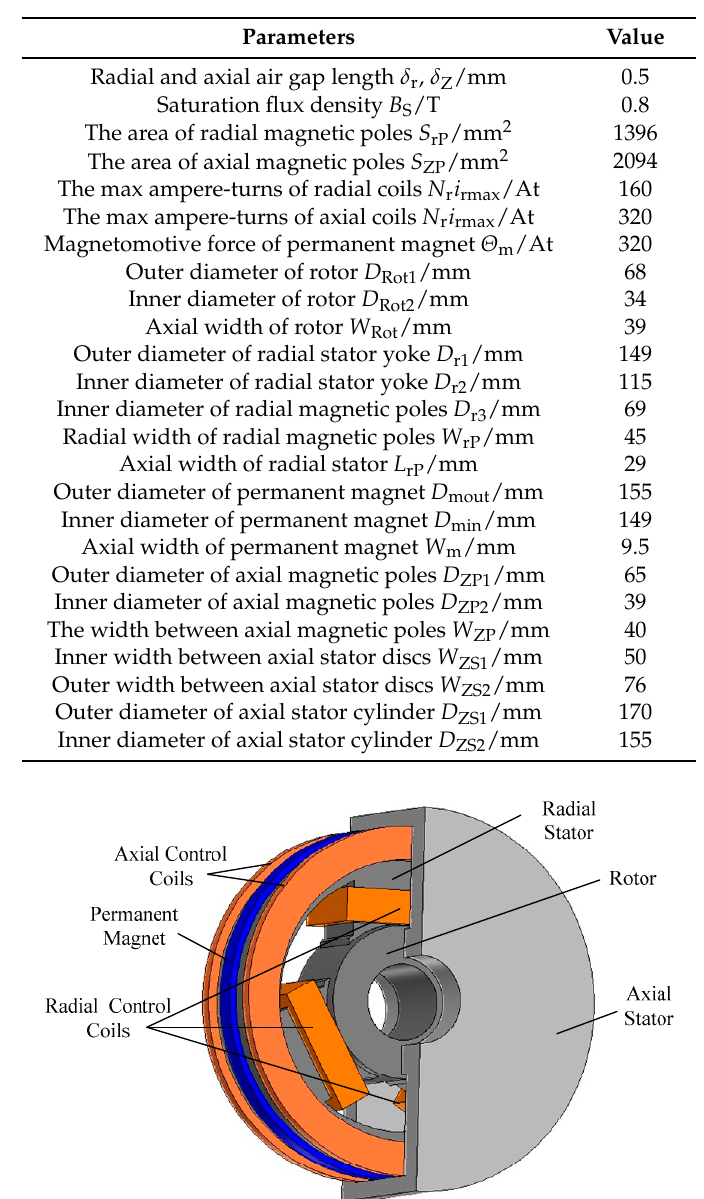
Table 1. Parameters of three-pole radial-axial hybrid magnetic bearings (HMB).